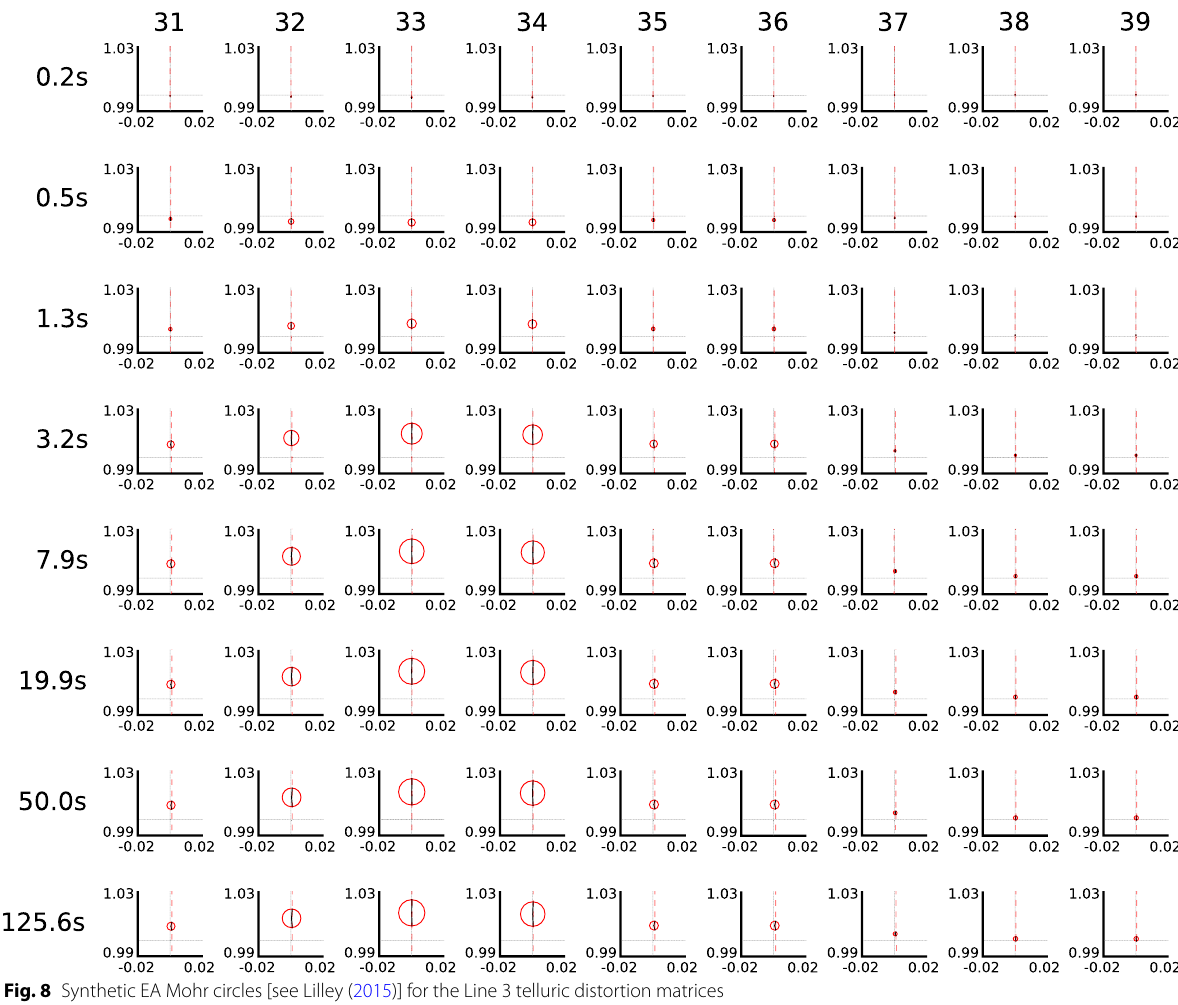
SVD and EA is performed on the telluric distortion Note that only the real components of the transfer func- matrices for the four days, with the results plotted onto tions are plotted. D yy shows similar behaviour to the fea- Mohr circle grids as shown in Figs. 13 and 14, respec- sibility study, where increases of approximately 2% above the noise window occur from 5 s and continue to longer tively. Although the site noise and dead band add com- 1 periods for all days. D yx is mostly within the ± % noise plexities to the analysis, the general trend shows the window for all days. D xy shows an almost 5% increase on Mohr circles increase in diameter for periods greater than 5 s. When comparing stations 04 and 27, an inter- day 194, with the other days mostly within the noise win- 1 dow. Finally, D xx decreases by < % on days 193 and 196. esting trend exists for periods between 2 and 14 s, where Transfer functions comparing stations 27 ( E B ) and 04 the Mohr circles progressively increase in diameter over the length of the pumping interval. EA shows eigenval- ( E M ) over the same time interval are shown in Fig. 12. Similar trends to Fig. 11 are observed, where an increase ues that are real and different, with eigenvectors trending in D yy exists in the order of 5% from 5 s to longer periods orthogonally indicating the telluric distortion matrix is close to 2D. This differs when comparing stations 04 and for all days. D xy shows a 2% increase over a similar period 13 where the eigenvectors are real but not orthogonal, range to D yy . Both D xx and D xy are within the noise win- which may be indicative of a general 3D structure. dows for most days.